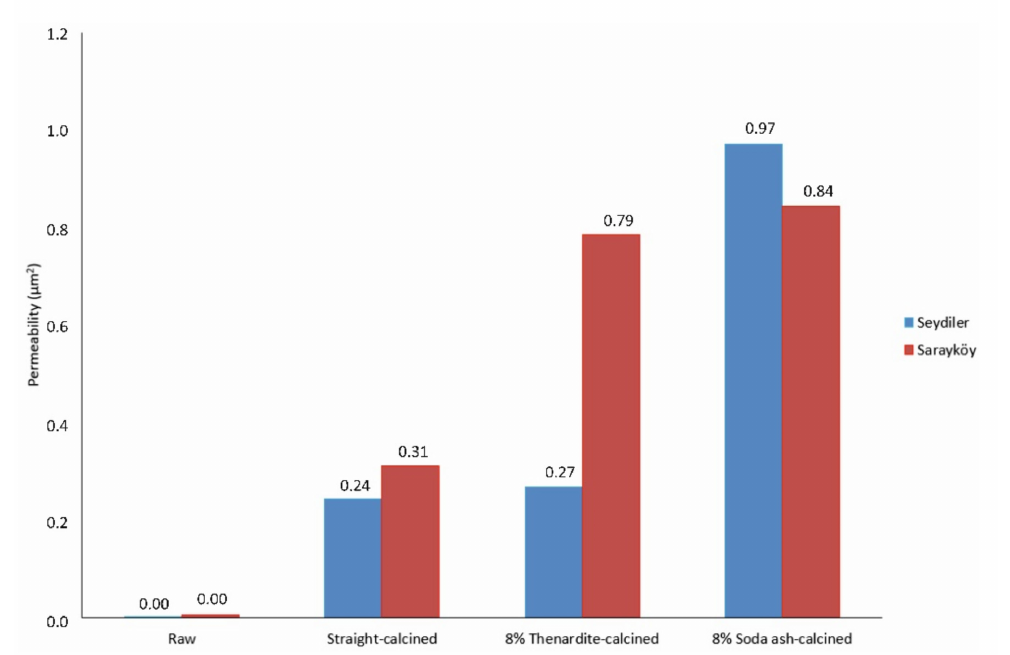
Figure 8. Permeability values of diatomite